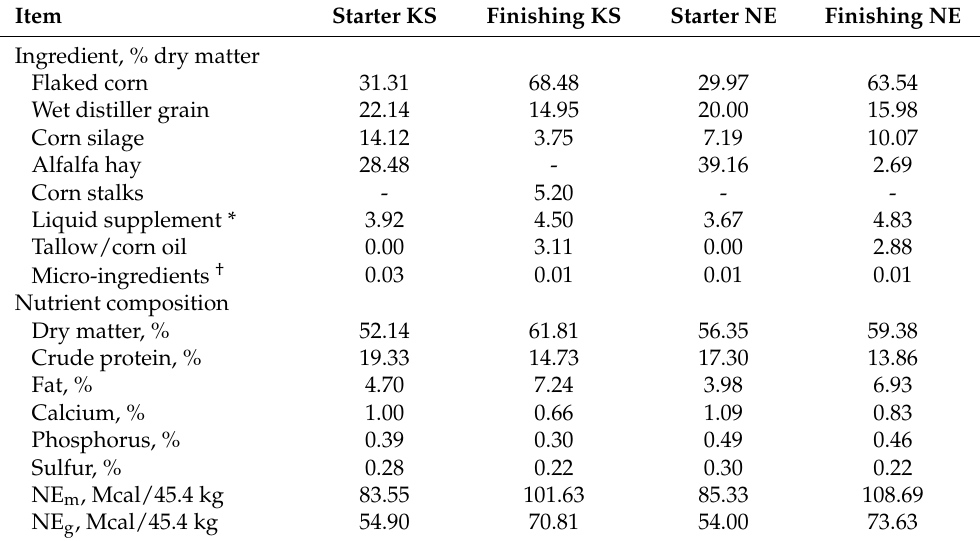
Table 1. Dietary ingredient formulations and calculated nutrient composition of starter and finishing rations fed to feedlot steers and heifers at Kansas (KS) and Nebraska (NE) feedlots.